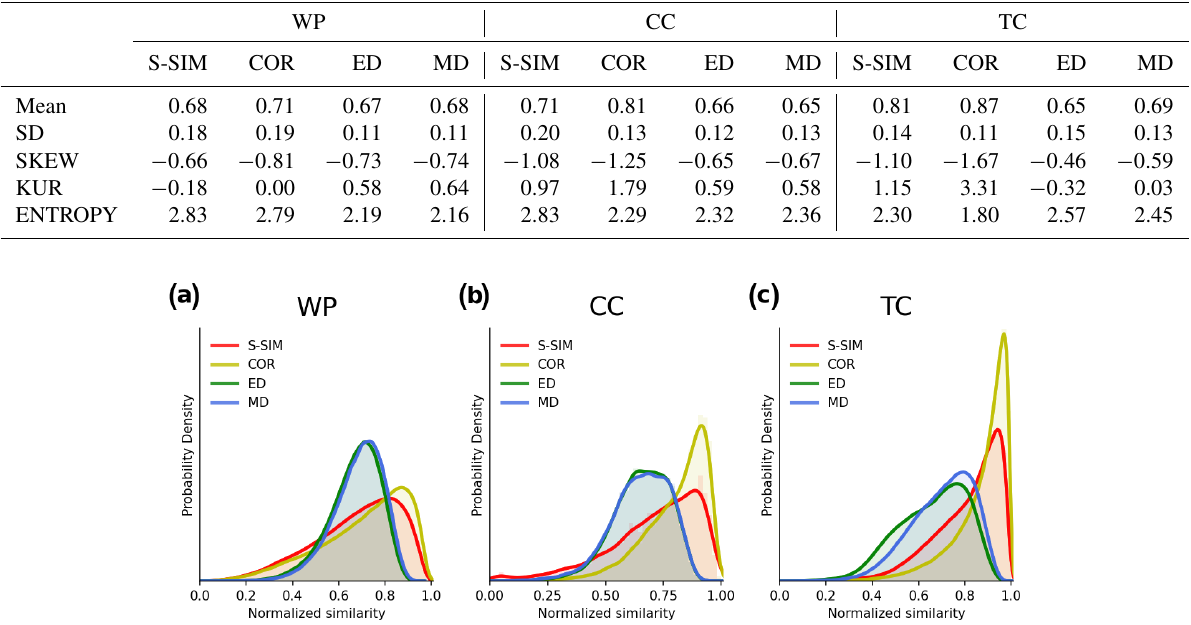
Figure 2. Comparison of the S distributions of normalized pairwise similarity using the structural similarity (S-SIM), the Pearson correlation coefficient (COR), the Euclidean distance (ED), and the Manhattan distance (MD) for three demonstration experiments: WP, CC, and TC. − 1 ) values of pairwise similarity are observed because S-SIM, COR, ED, and MD are symmetric measures, With a population size of N , N(N 2 and self-similarity is excluded. Values are normalized from 0 to 1. The maximum similarity is 1, which corresponds to completely similar, and the minimum similarity is 0, which corresponds to the lowest pairwise